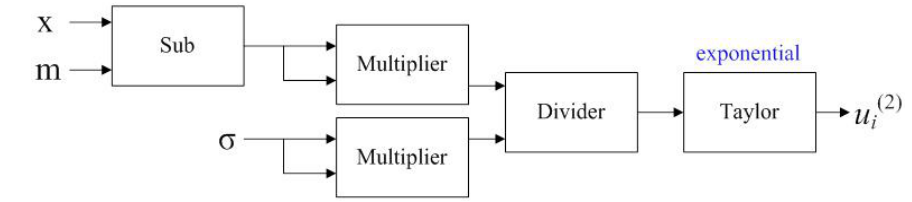
Figure 6. Block diagram of Gaussian function.